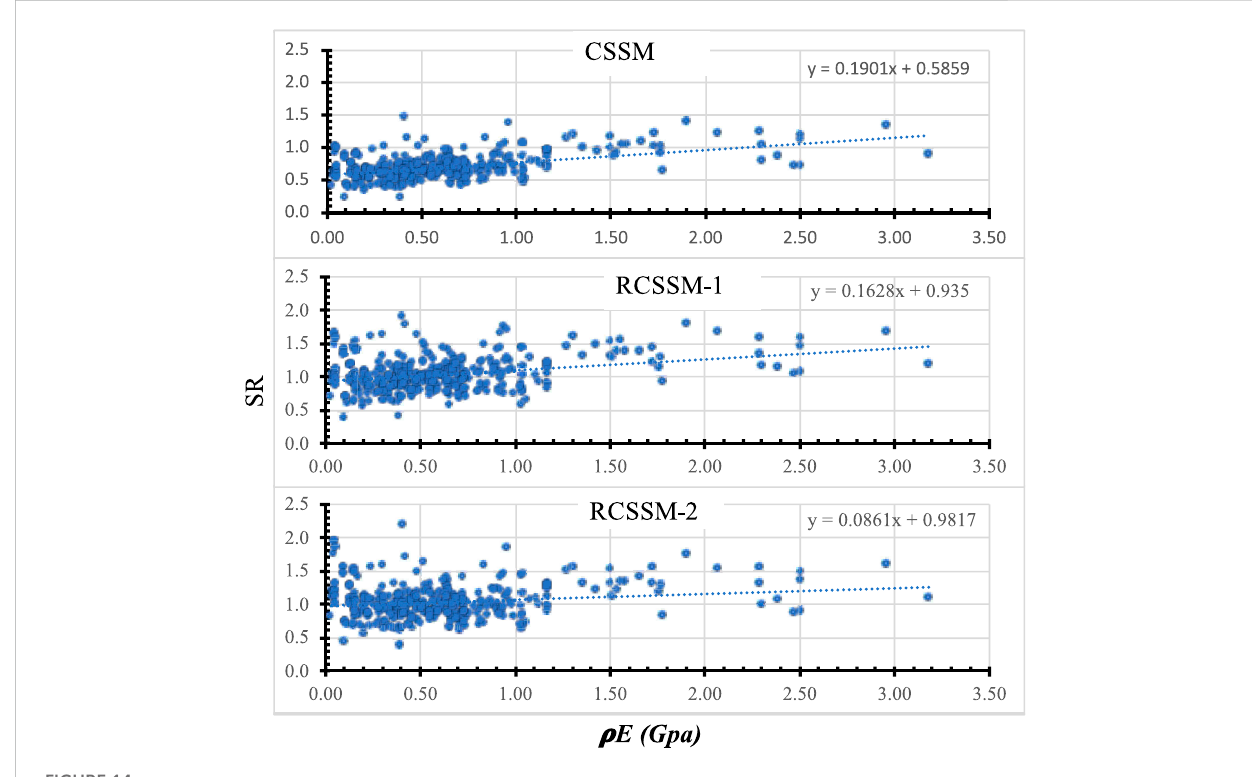
FIGURE 14 SR calculated using proposed models versus fl exure reinforcement axial